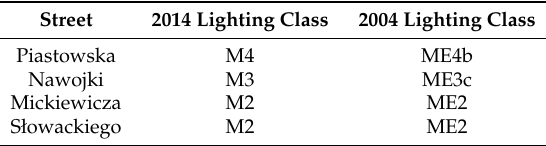
Table 3. Normal lighting class assigned to the